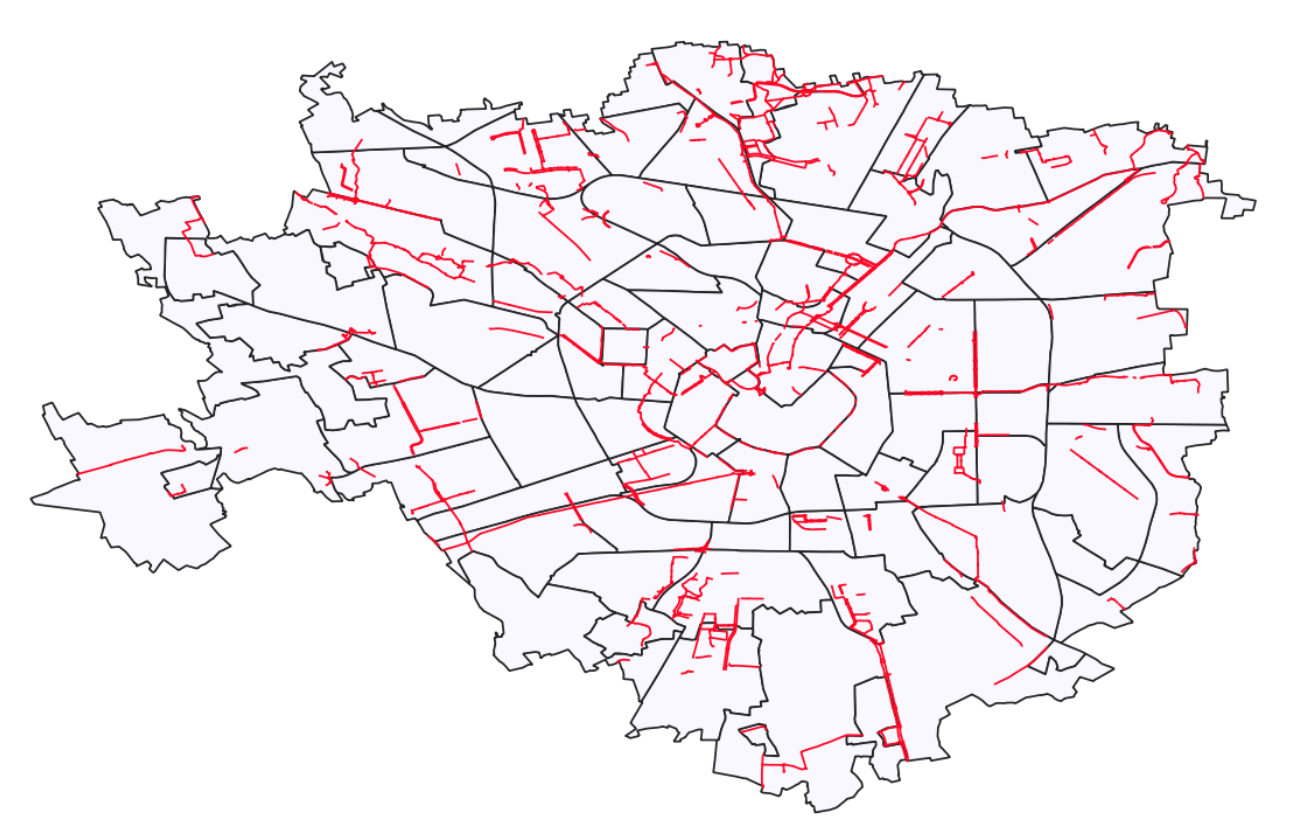
Figure 4. Districts (black lines) and bike lanes (red lines) in Milan (Italy), described by documents in collections Milan_Districts and Milan_BikeLanes sketched in Listing